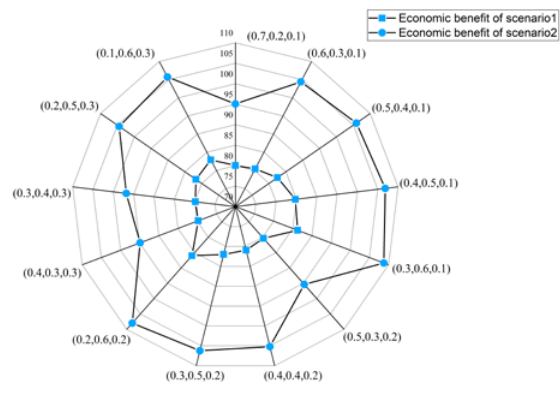
Figure 5. Economic benefits with di ff erent sets of objective weights ((0.7, 0.2, 0.1) means ω 1 = 0.7, ω = 0.2, ω = 0.1).